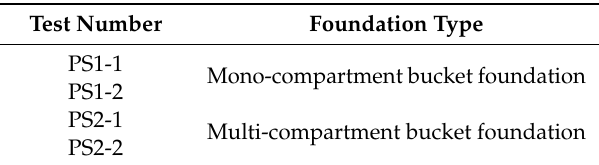
Figure 5. Layout of sensors. ( a ) mono-compartment bucket foundation; ( b ) multi-compartment bucket foundation. Table 3. Contents of penetration test in sand.